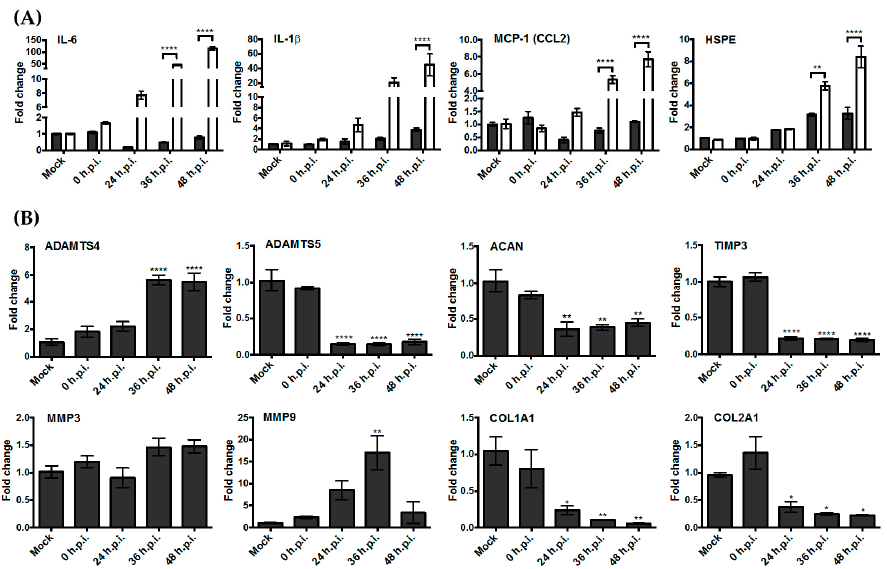
Figure 3. Upregulation of key pro-inflammatory genes and extracellular matrix breakdown genes during Ross River virus (RRV) infection in human chondrocyte cells (grey) and skeletal muscle cells (white) at 0, 24, 36, and 48 h post-infection (h.p.i.). Samples were normalised using values from mock-infected groups. ( A ) Relative gene expression of key pro-inflammatory markers. Statistical analysis was performed by two-way ANOVA statistical analysis with Bonferroni’s test. ( B ) Relative gene expression of articular cartilage components and associated breakdown markers. Statistical analysis was performed by two-way ANOVA statistical analysis with Bonferroni’s test. < 0.01, **** p < 0.0001.